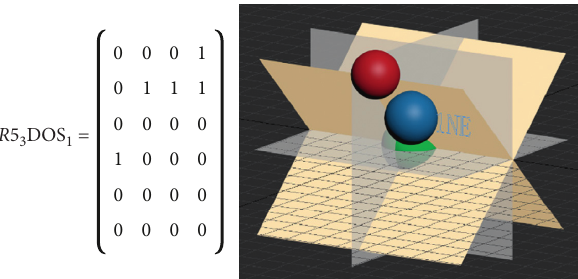
Figure 13: R5 3 DOS-intersection model in Example 1(a).